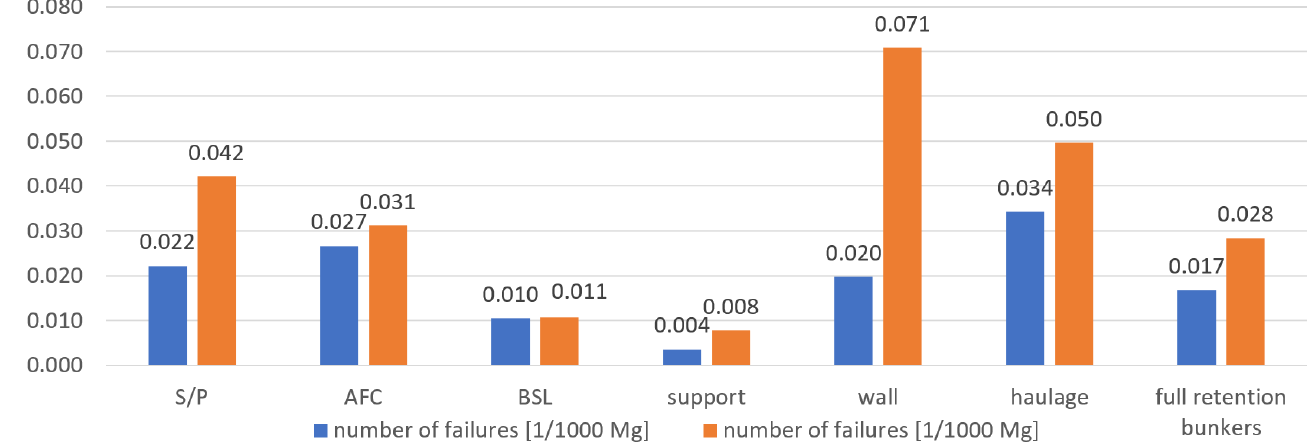
Figure 13. Comparison of the total duration of failures per one day of longwall operation.